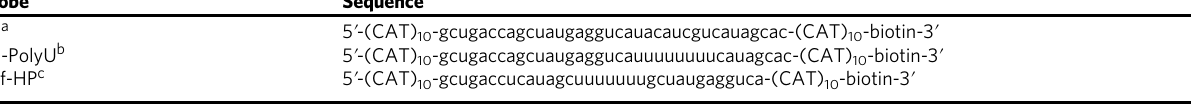
Table 1 Sequences of various complex probes used in the study